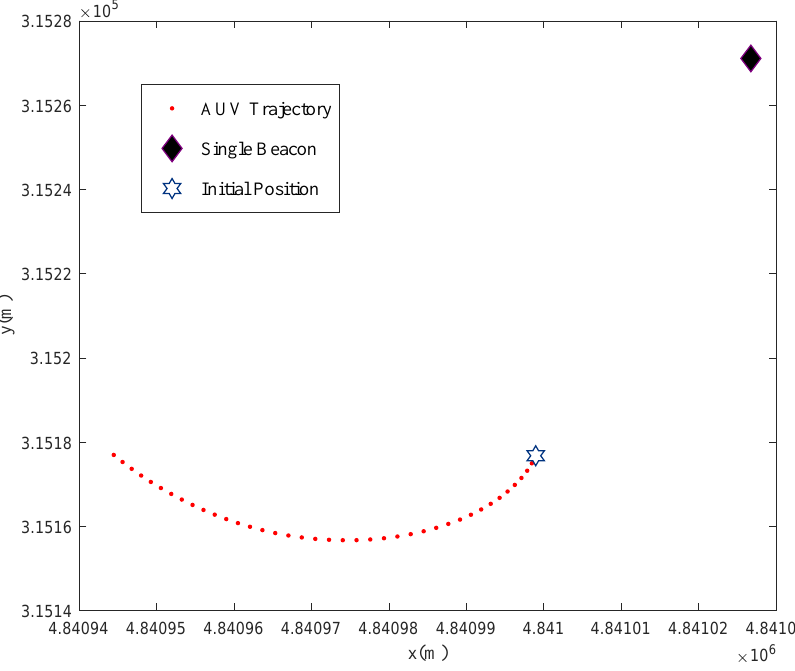
Figure 6. The relationship between the AUV and single beacon.